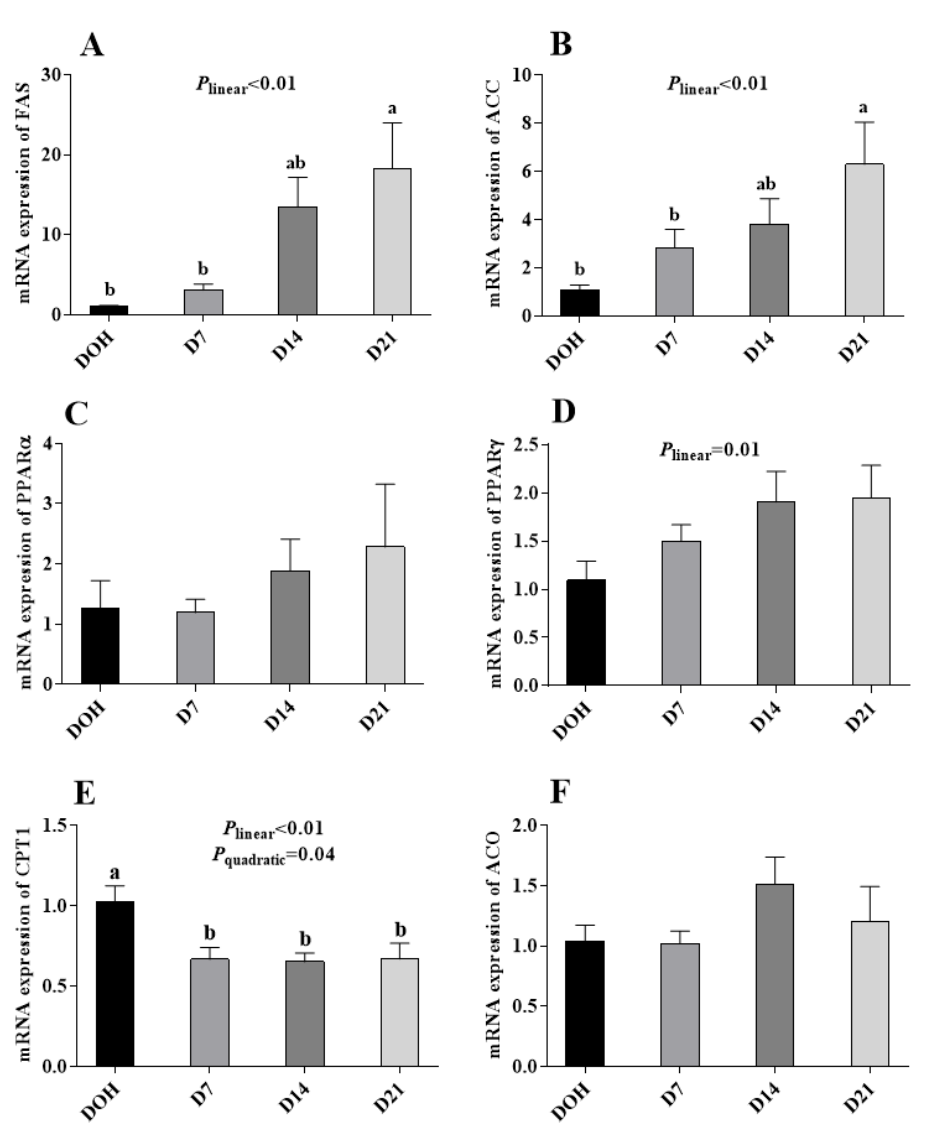
Figure 4. The age-related changes in the mRNA expression of hepatic lipid metabolism-related genes of domestic pigeon squabs. ( A ) mRNA expression of fatty acid synthase (FAS), ( B ) mRNA expression of acety l-CoA carboxylase (ACC), ( C ) mRNA expression of carnitine palmitoyltransferase 1 (CPT1), ( D ) mRNA expression of acyl-CoA (ACO), ( E ) mRNA expression of peroxisome proliferator activated receptor α (PPAR α ), ( F ) mRNA expression of peroxisome proliferator activated receptor γ (PPAR γ ). DOH = day of hatch; D7 = day 7 post-hatch; D14 = day 14 post-hatch; D21 = day 21 post-hatch. Values are means ± SEM of 10 squabs, n = 10. a,b Means within the same day sharing no common superscripts differ significantly (Tukey test, p < 0.05).